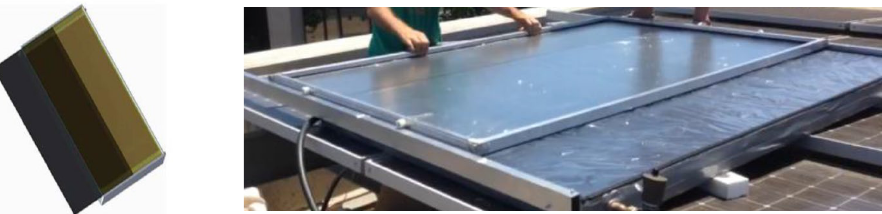
Figure 1. ( left ) adaptive cover concept; ( right ) black surface as absorber/emitter, plastic film wind- shield for night-time radiative cooling, and glass for solar collection.